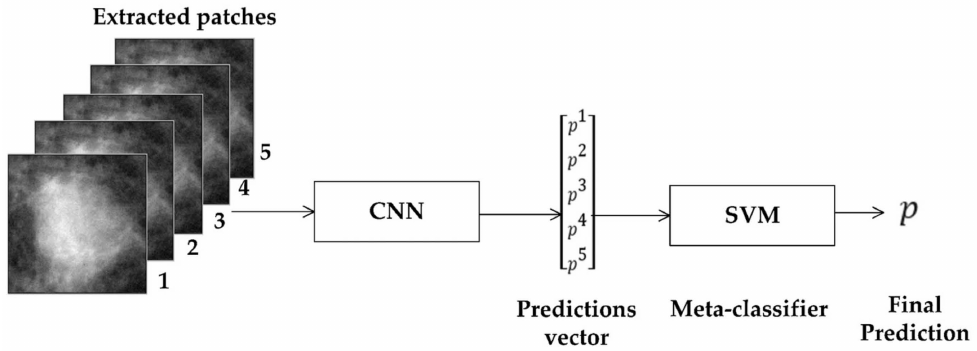
Figure 10. Stacked generalization